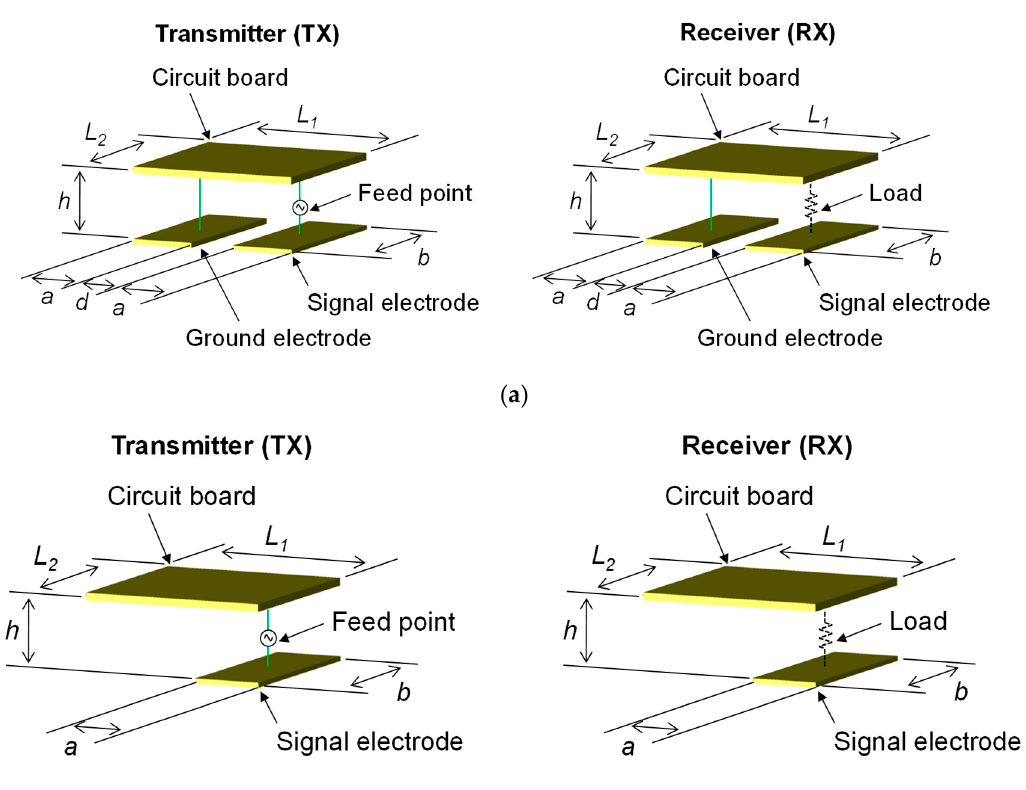
Figure 4. Structures of the transmitter ‐ and ‐ receiver electrode models: ( a ) two ‐ electrode transmitter and receiver; ( b ) single ‐ electrode transmitter and receiver